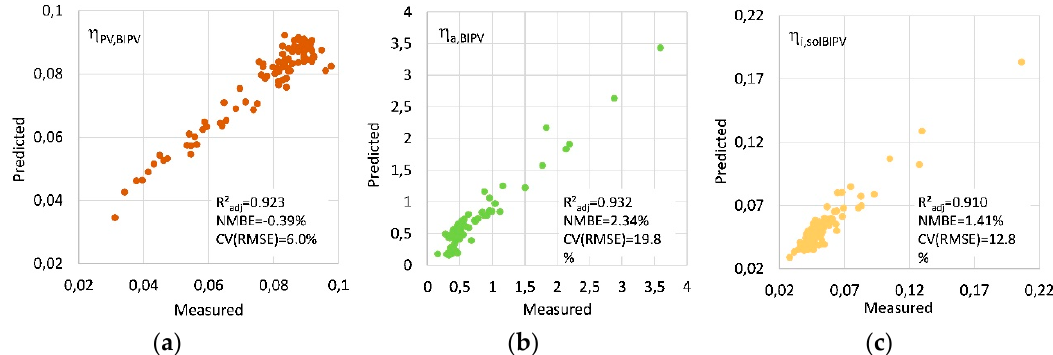
Figure 14. Correlation of components of overall e ffi ciency of solar energy utilization η sol,BIPV determined by experimental results and multi-parametric regression models; statistical indicators are also shown for ( a ) η PV,BIPV , ( b ) η a,BIPV , and ( c ) η i,sol;BIPV